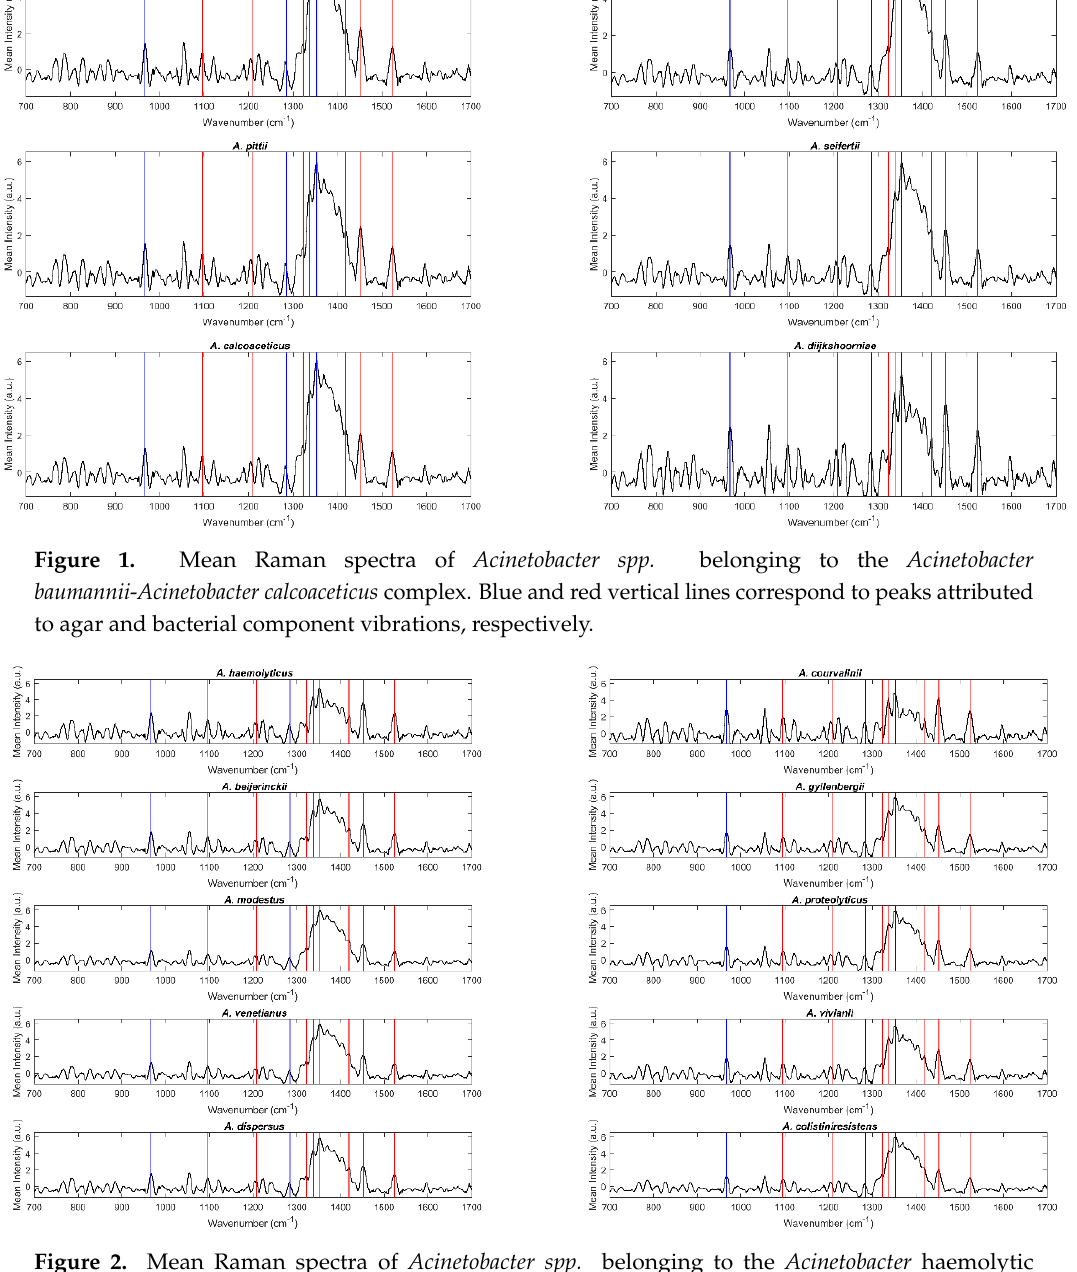
Figure 2. Mean Raman spectra of Acinetobacter spp. belonging to the Acinetobacter haemolytic clade. Blue and red vertical lines correspond to peaks attributed to agar and bacterial component vibrations, respectively.